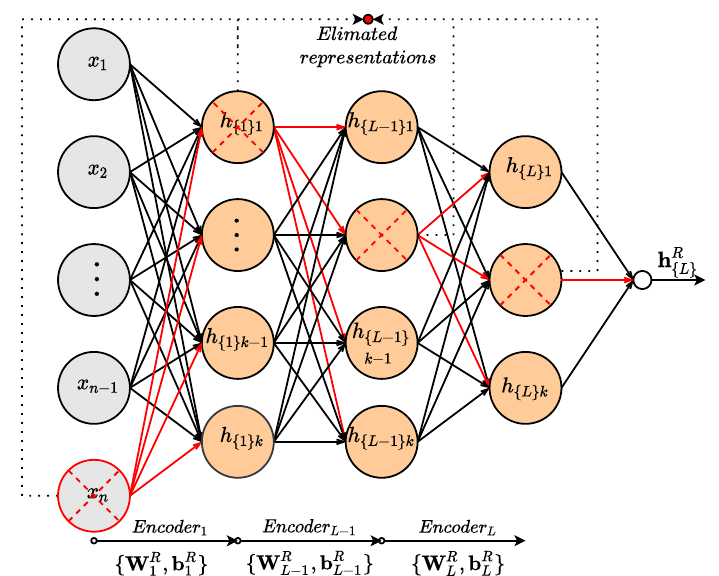
Figure 4. MI-base relevant representation